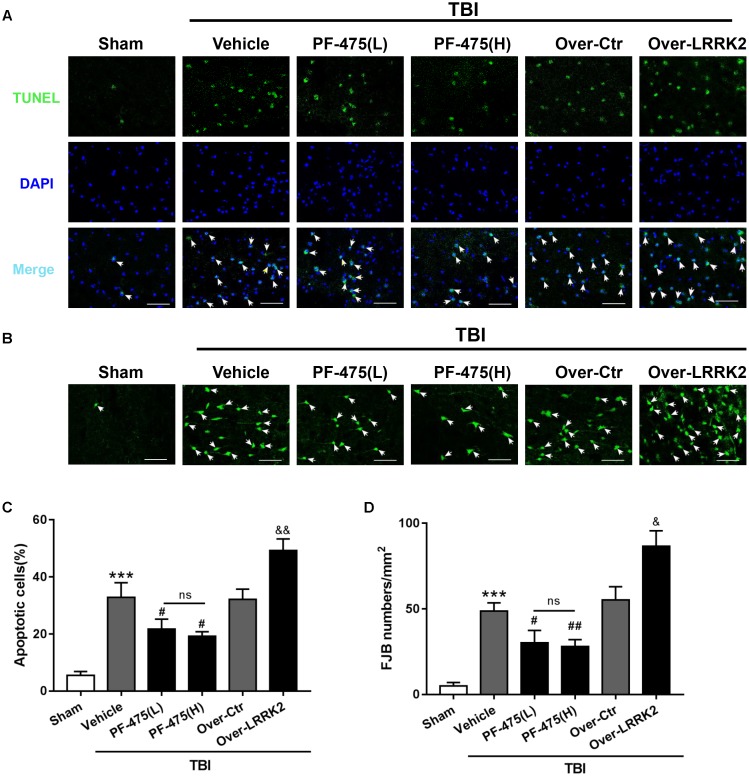
Effects of LRRK2 intervention on brain cell death and neuronal degeneration after TBI. (A) Representative photomicrographs of TUNEL staining in the experimental groups are shown. Sections were labeled with TUNEL (green) to assess apoptotic brain cells; sections were counterstained with DAPI (blue) to detect the nuclei. The arrows indicate the TUNEL-positive cells. Scale bar = 50 μm. (B) Representative photomicrographs of FJB staining in the experimental groups are shown. The arrows indicate the dead neurons. Scale bar = 50 μm. (C) The percentage of TUNEL-positive cells in the brain is shown (apoptotic cells)/(total cells) × 100%. (D) The neuronal degeneration index is presented as the number of FJB-positive cells per visual field. Statistical analyses were performed using one-way ANOVA followed by Tukey’s post hoc test. Data are expressed as the mean ± SD, n = 6 animals per group. ∗∗∗P < 0.001 vs. sham; #P < 0.05, ##P < 0.01 vs. the Vehicle group; &P < 0.05, &&P < 0.01 vs. the Over-Ctr group.